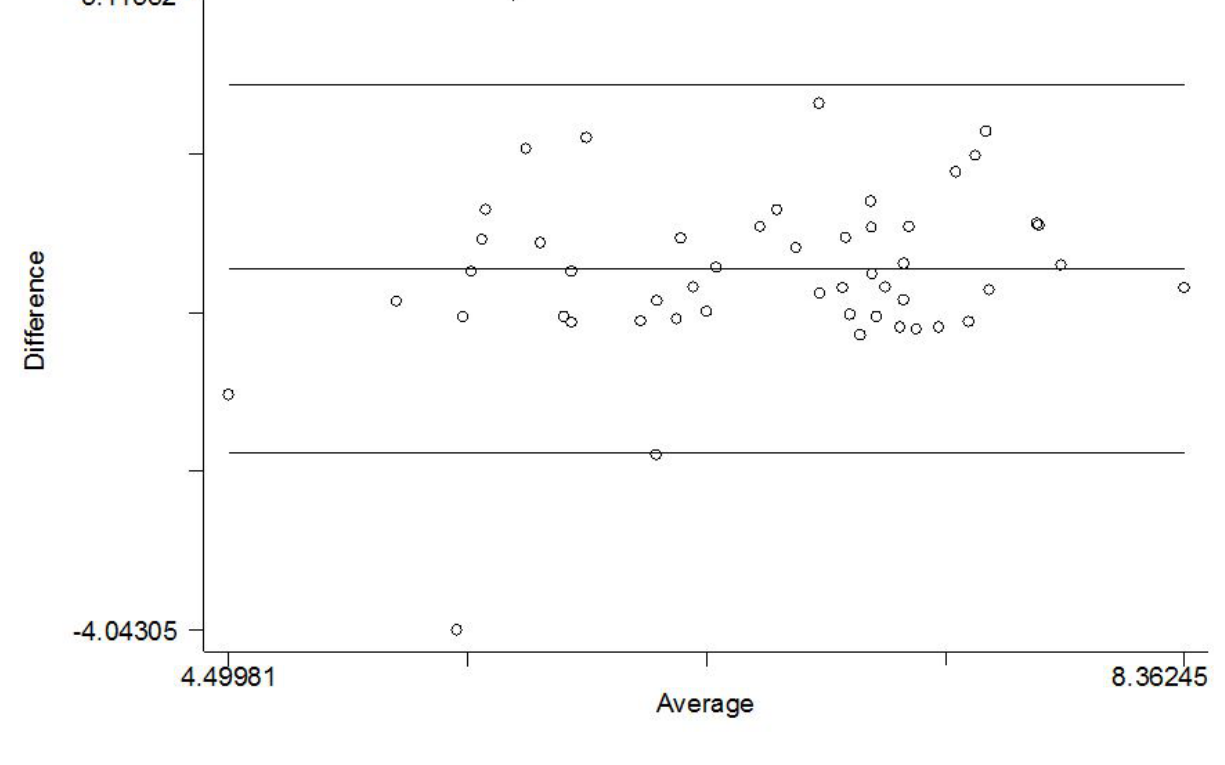
Figure 5. Bland-Altman plot of natural log transformed score showing the difference between baseline and follow-up MAAS, plotted against the mean. Note: the lines represent the limits of agreement (95%) and average difference between the two